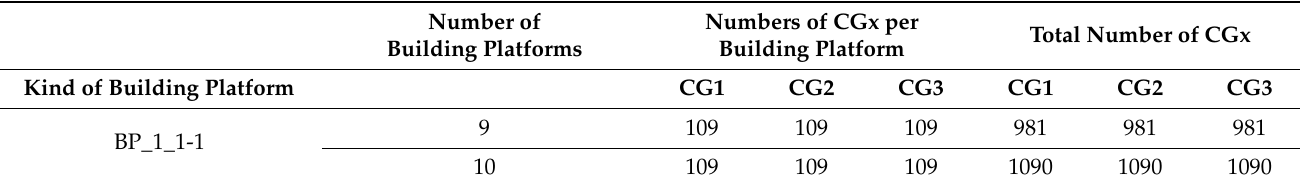
Table 3. Numbers of different types of cylinder geometries (CG) arranged on the different building platforms for problem 1–solution 1.